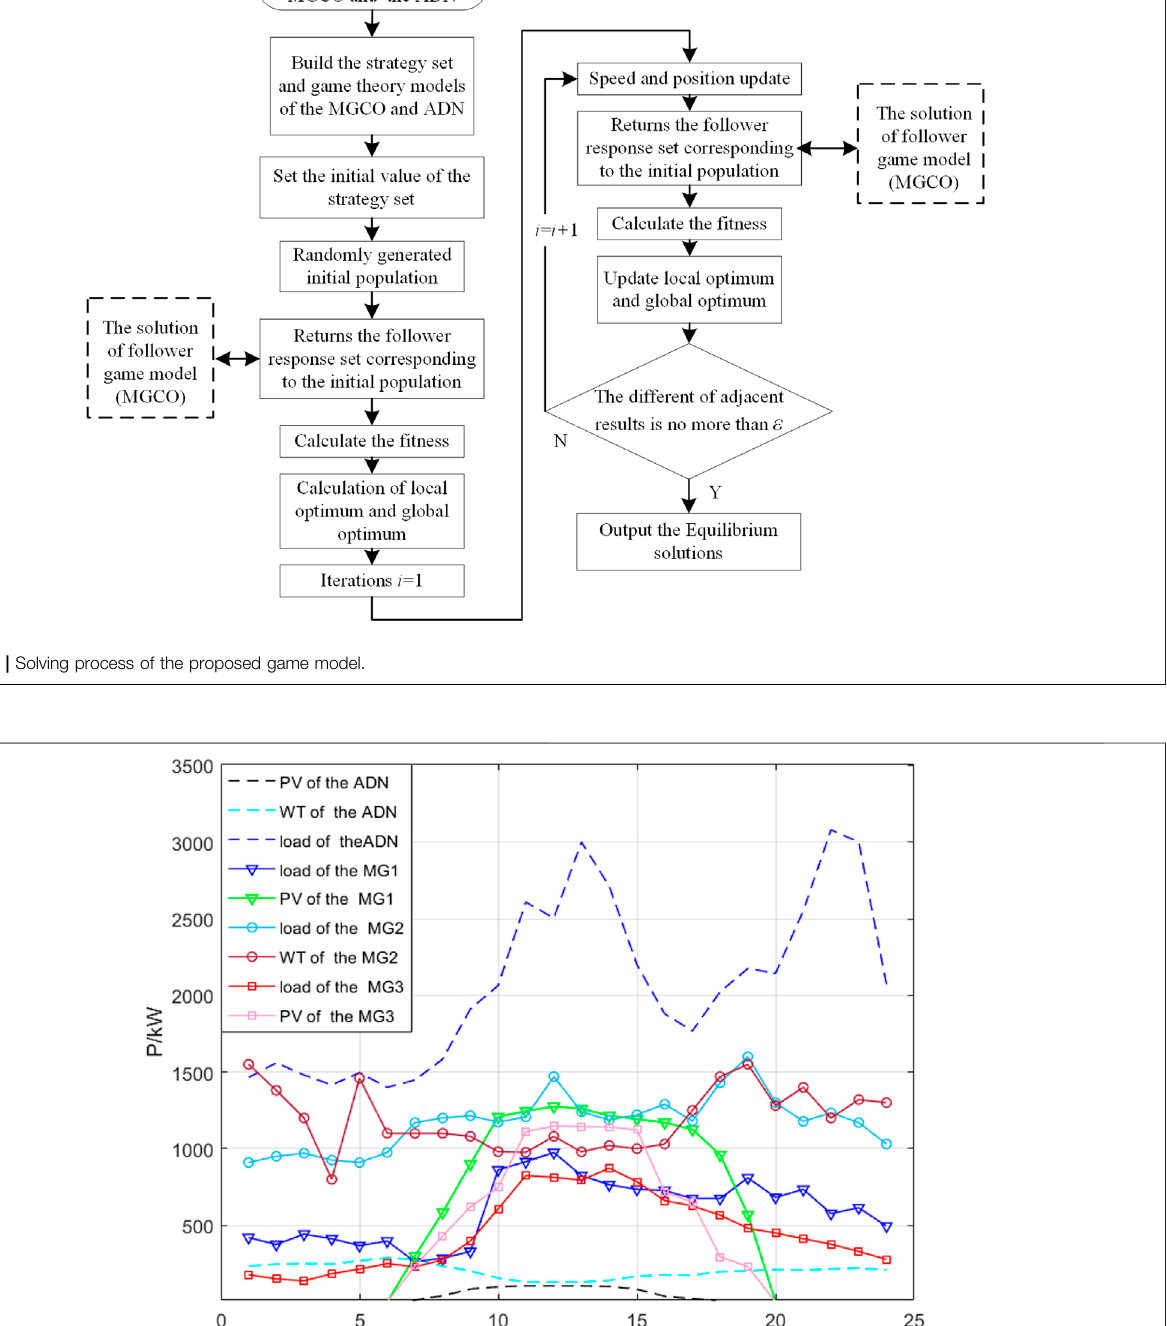
Frontiers in Energy Research |